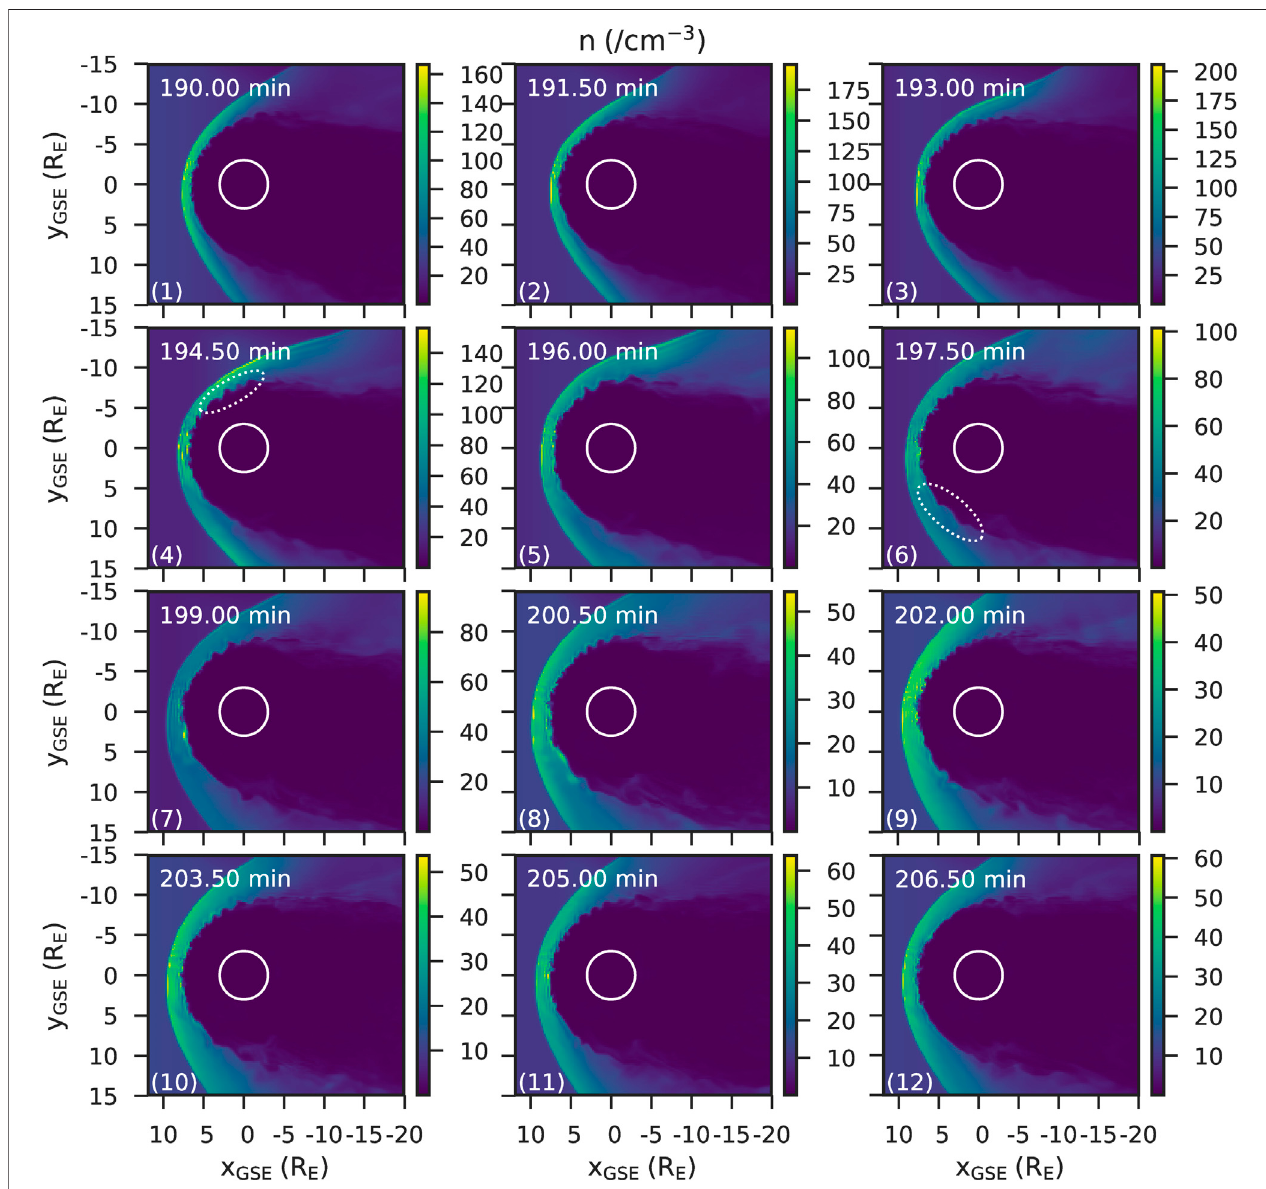
FIGURE 2 | The number density in the ecliptic plane every 1.5 min from t (cid:2) 190min to t (cid:2) 206 . 5min. The number density color bar scale changes every timestep. With the solar wind streaming from the left, the sharp increase in number density to the left denotes the bow shock. The brightly colored region after it is the magnetosheath. The subsequent sharp decrease moving to the right is the magnetopause. The white circle is the inner boundary of the simulation, of radius 3 R E .